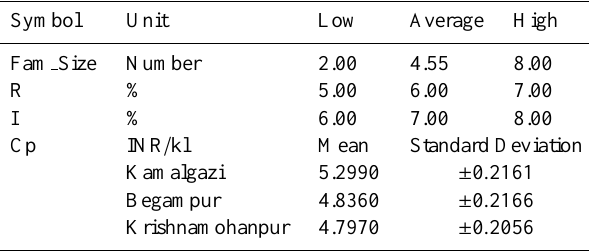
Figure 10. Tornado diagrams for sensitivity analysis of